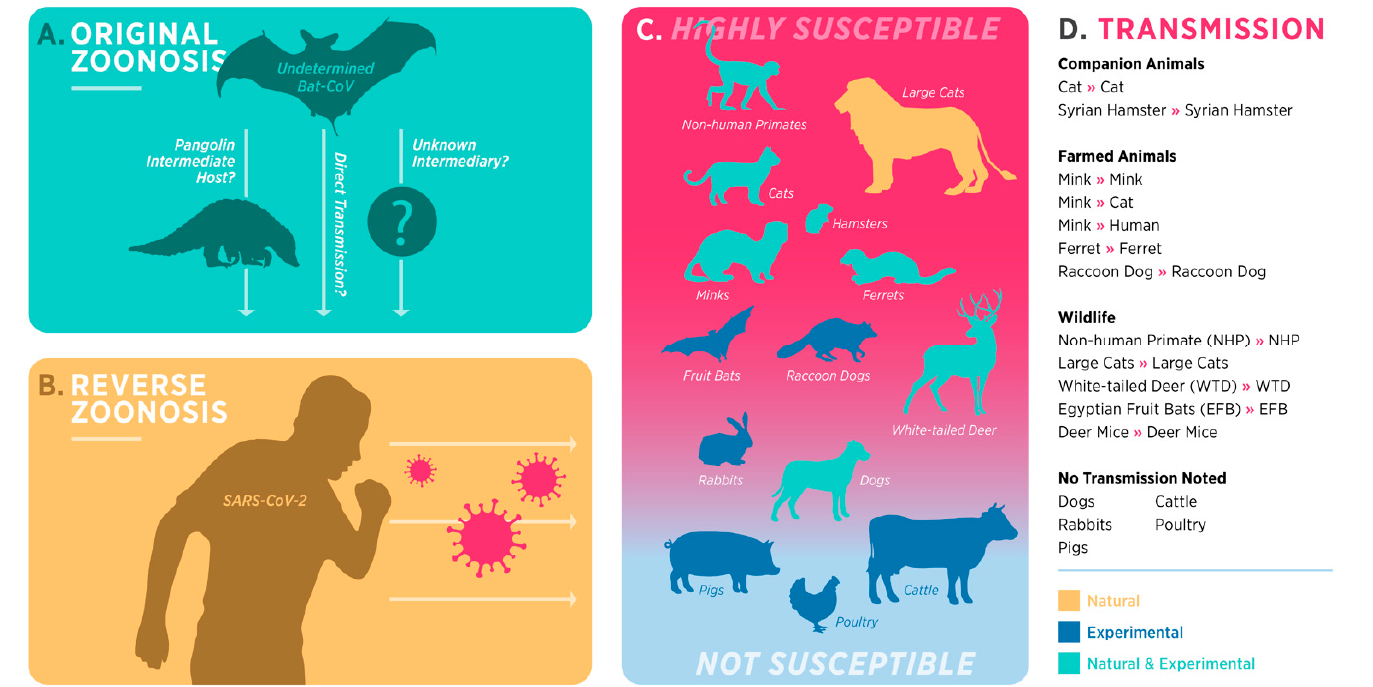
Figure 2. Current summary of SARS-CoV-2 origin, animal susceptibility, and transmission. ( A ) The original zoonosis for the SARS-CoV-2 is yet to be confirmed. It is suspected to be evolved in a selected species of bats. Bats may have shed CoVs and infected humans (solid arrows) via a suspected intermediate host (pangolin), direct transmission, or other intermediate species that remain to be discovered (see references [33,34] ). ( B ) SARS-CoV-2 transmission from human to animal (reverse zoonosis events) have been documented in several instances to date (see references [35–40] ). ( C ) The susceptibility of animal species for SARS-CoV-2 infection is shown in a descending order, with NHPs and felids being most susceptible to infection while livestock species (cattle, pigs, and poultry) generally being the least susceptible. ( D ) Animals are color coded to represent the mode of infection (natural vs. experimental) and a summary of animal–animal transmission confirmed by relevant methods (viral RNA and sequencing) is shown at the right.